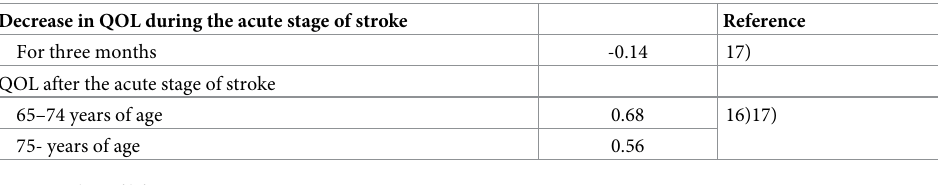
Table 2. Estimated QOL